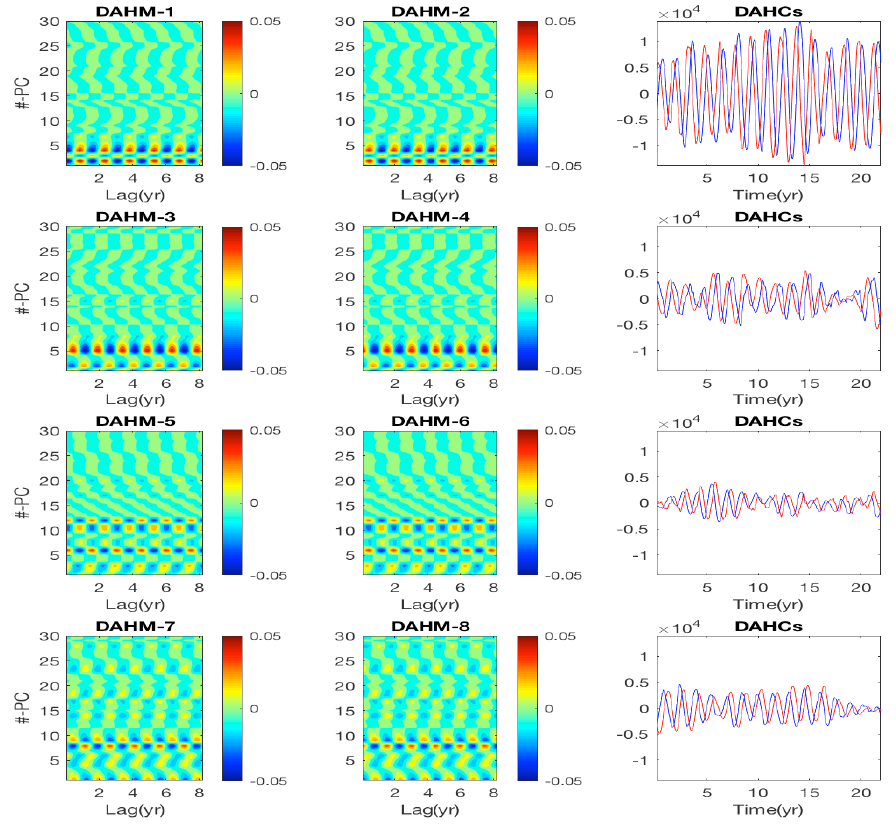
Figure 4. Same as in Figure 3, but for f = 0.674 y − 1 ; associated here with the green dots in the DAH power spectrum shown in Figure 2.